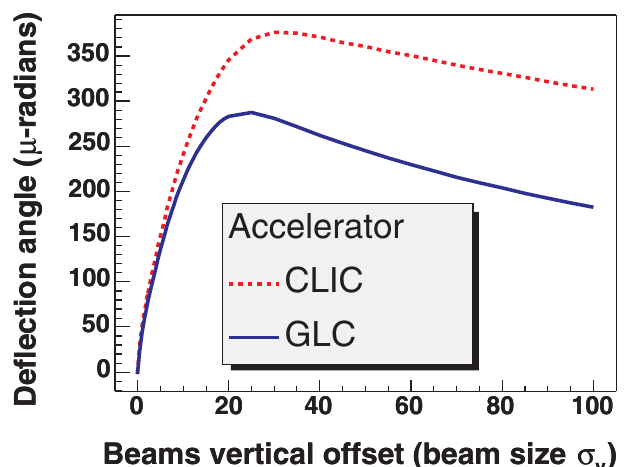
FIG. 2. (Color) Beam deflection angle ( (cid:4) bunch offset at the interaction point ( (cid:1) for this simulation are those of the GLC and of CLIC as given